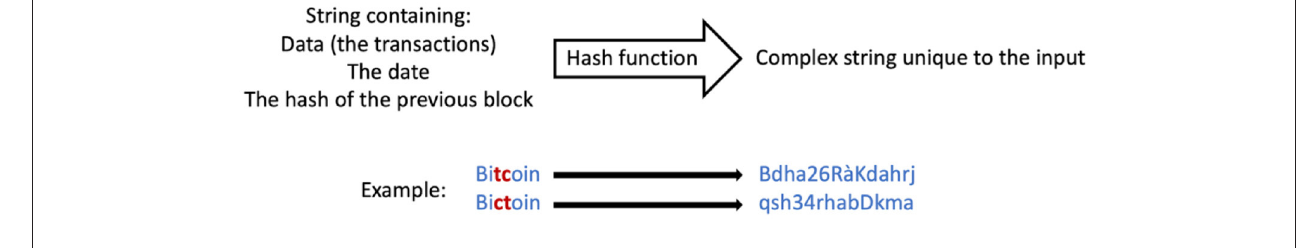
FIGURE 3 | Hashing.